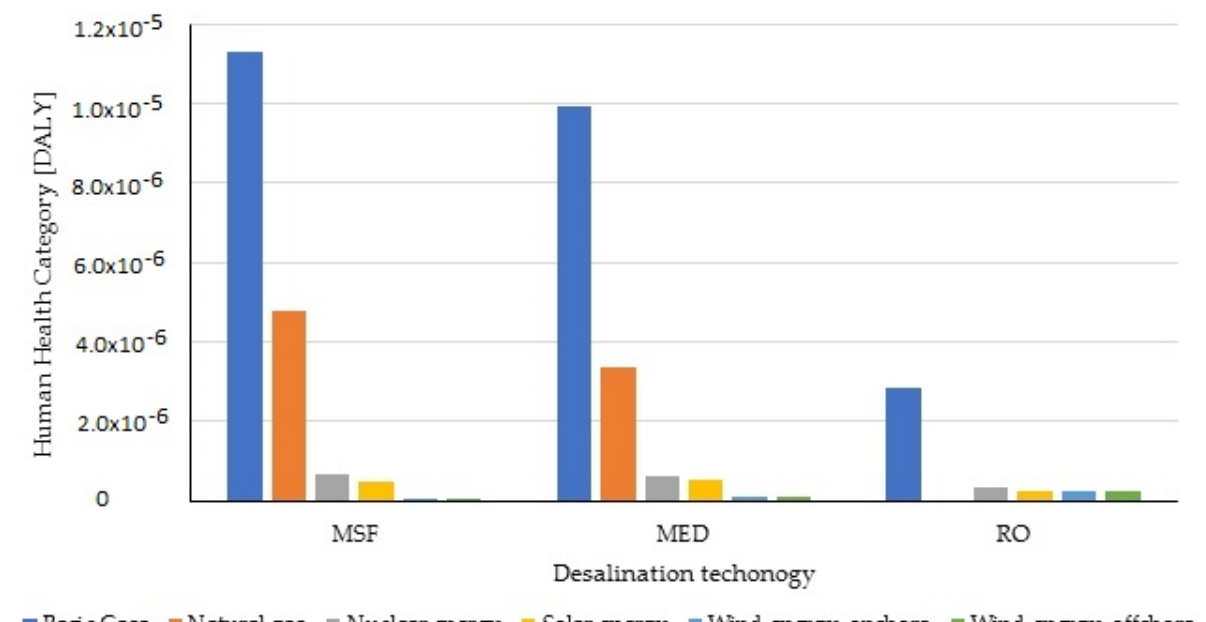
Figure 13. Comparison of desalination technologies used with different energy sources with the human health category based on the ReCiPe 2016 method.